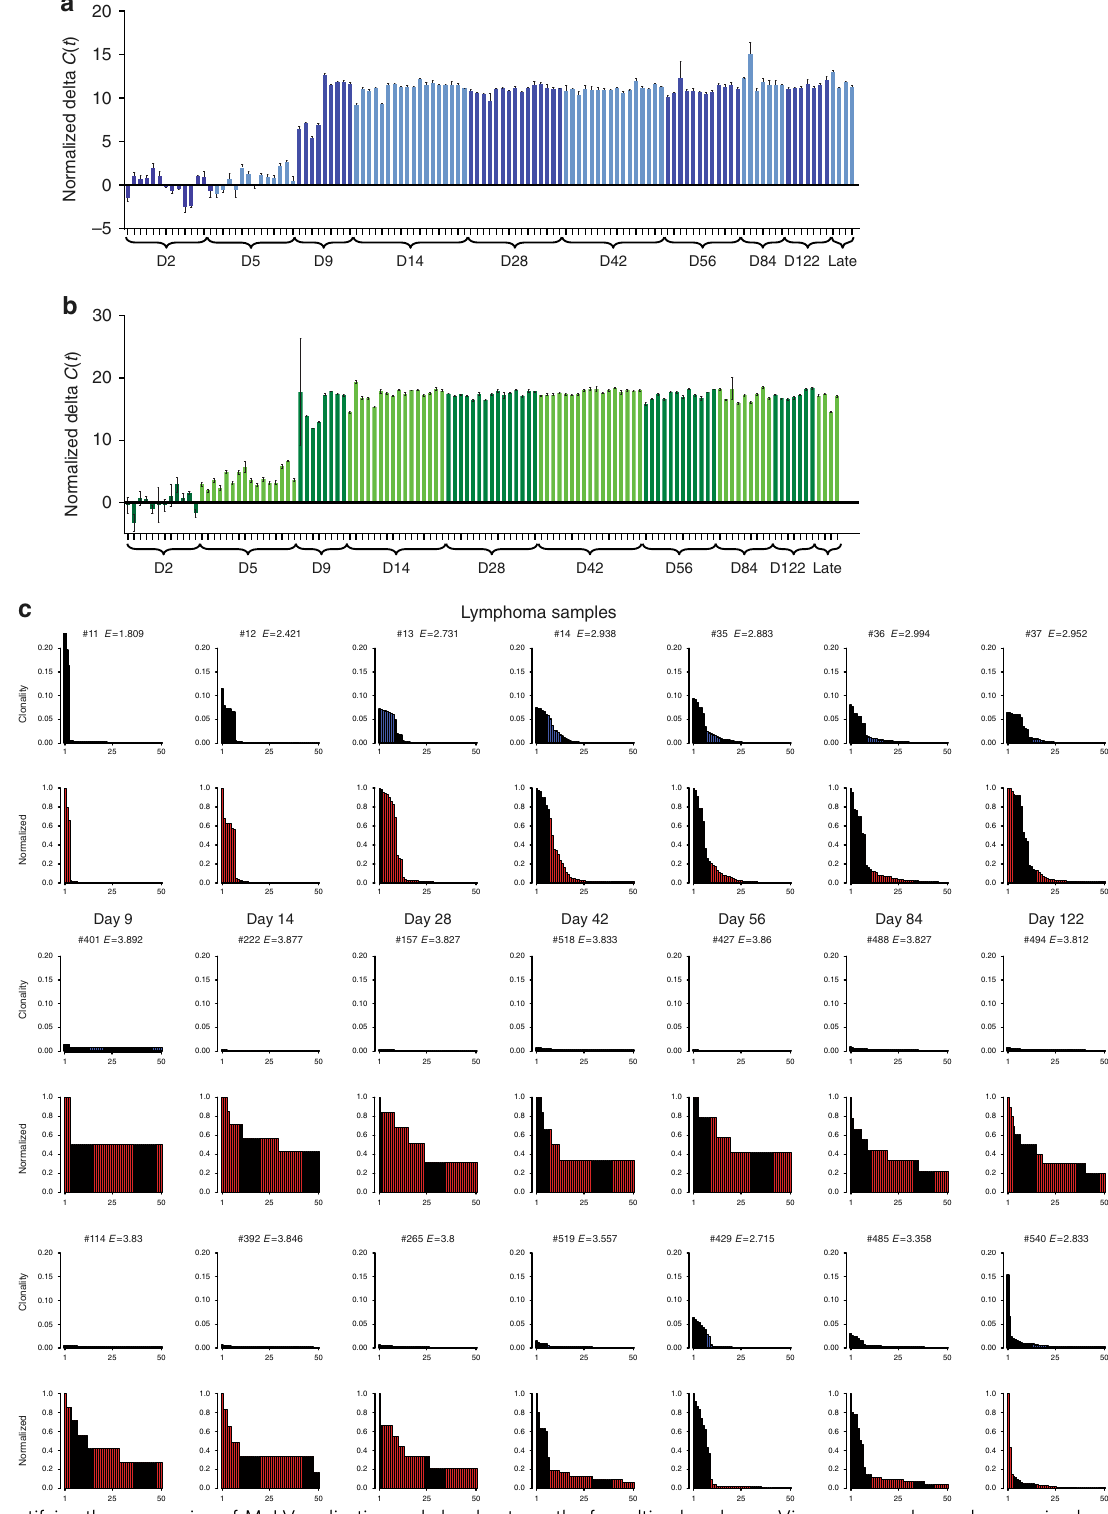
Fig. 2 Quantifying the progression of MuLV replication and clonal outgrowth of resulting lymphoma. Virus copy number and expression level was quanti fi ed by QPCR of genomic DNA ( a ) and RTQPCR of cDNA ( b ) extracted from spleen samples of time course animals. Error bars represent s.d. of 3 technical replicates per DNA/RNA sample. ( c ) Pro fi les of the relative abundance of the top 50 most clonal integrations from a cross section of mature lymphoma (upper 2 rows) and time course samples (lower 4 rows) are represented as bar graphs. Non-adjusted clonality is indicated in blue, normalized clonality (such that the most abundant integration has a value of 1) are the graphs in red. Asymptomatic animals from early time points display a relatively fl at pro fi le whereas later time points and mice with symptomatic lymphoma show clear signs of clonal outgrowth. Shannon entropy values ( E ) are displayed on each